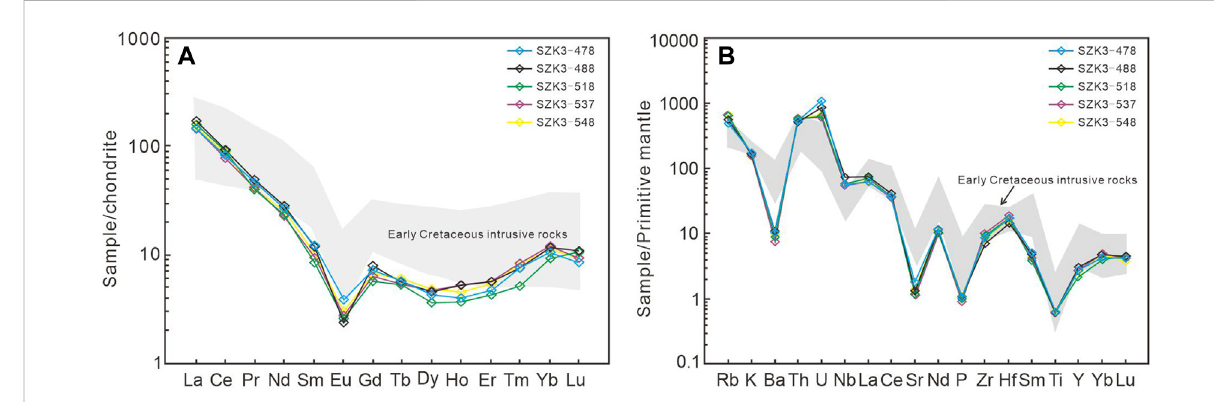
FIGURE 7 Chondrite-normalized rare Earth element and Primitive mantle-normalized trace element abundance spider diagram for the alkali-feldspar granite. Chondrite date from Boynton (1984); primitive-mantle date from Sun and McDonough (1989), the data of shadow area are from Niu et al. (2017), Guo et al. (2018), and Cao and Liu, (2020).